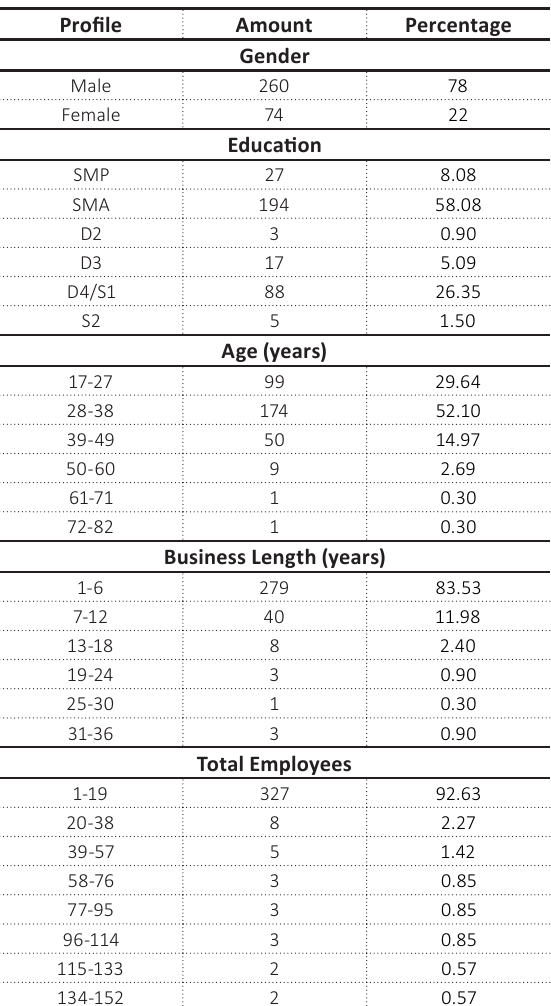
Table 1. Characteristics of the